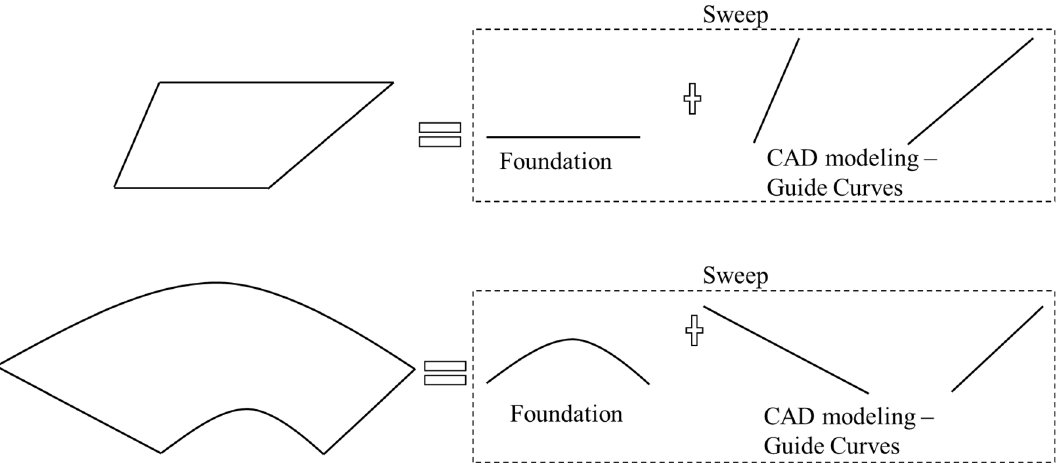
Figure 2. AM volume satisfying requirements in CAD modeling system.